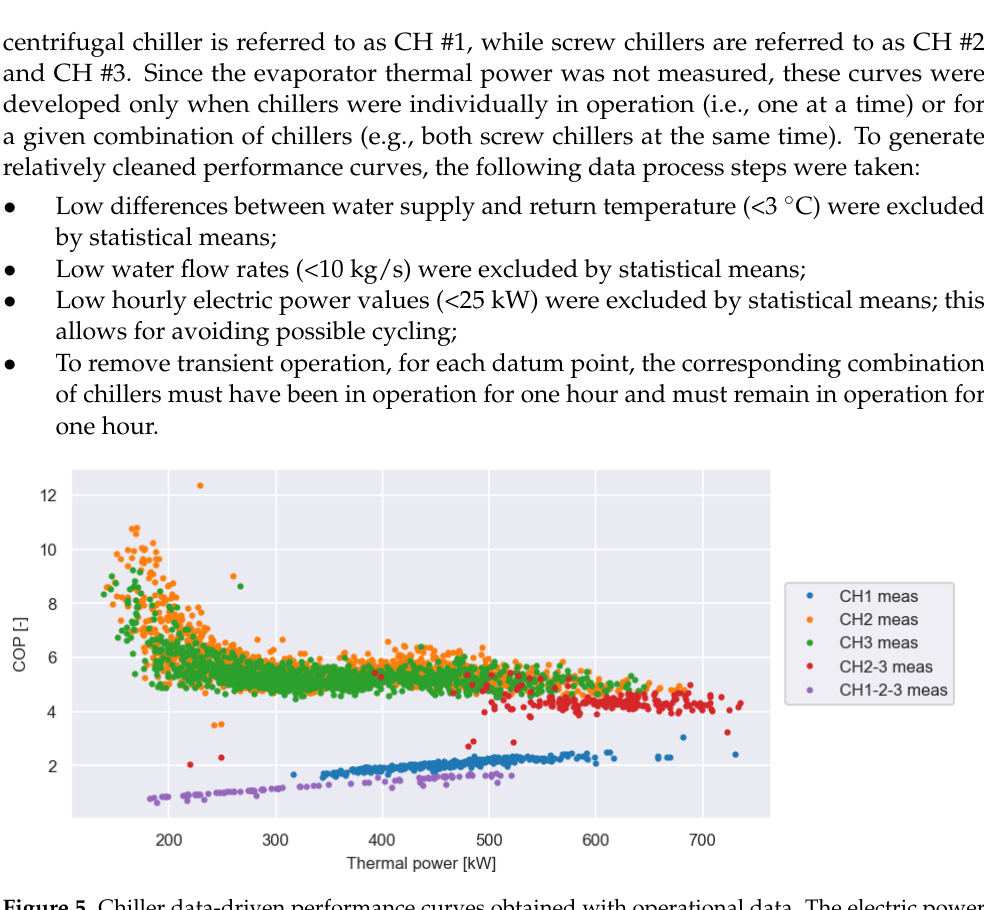
Figure 5. Chiller data-driven performance curves obtained with operational data. The electric power accounts for the chiller(s) in operation only.